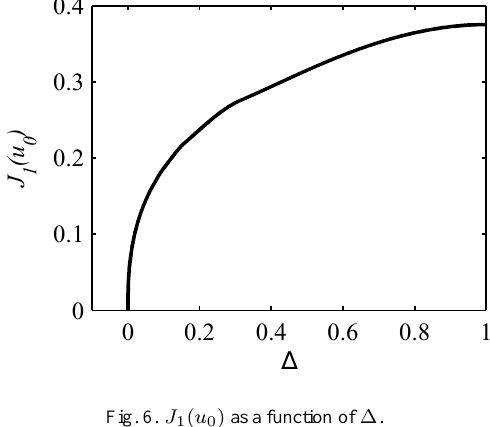
Fig. 6. J 1 ( u 0 ) as a function of ∆ .